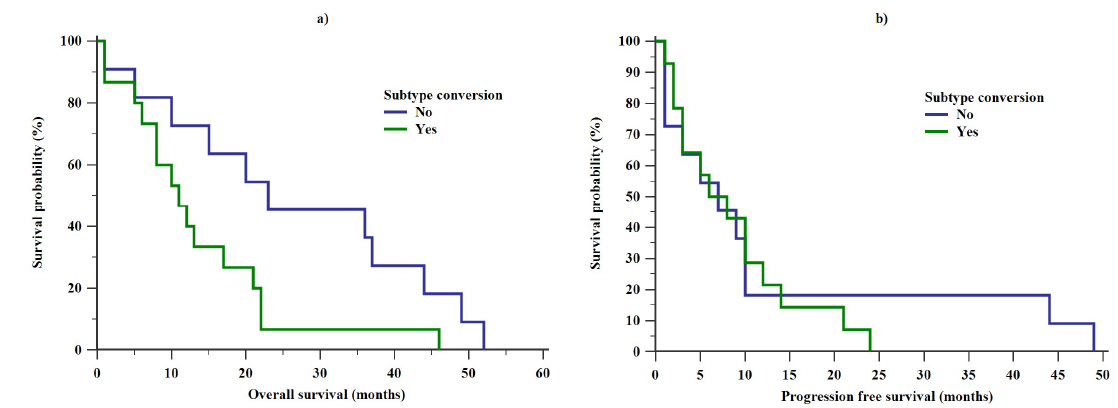
Figure 1. Differences in ( a ) overall survival (OS) and ( b ) progression free survival (PFS) between subtype stable patients and subtype converters .